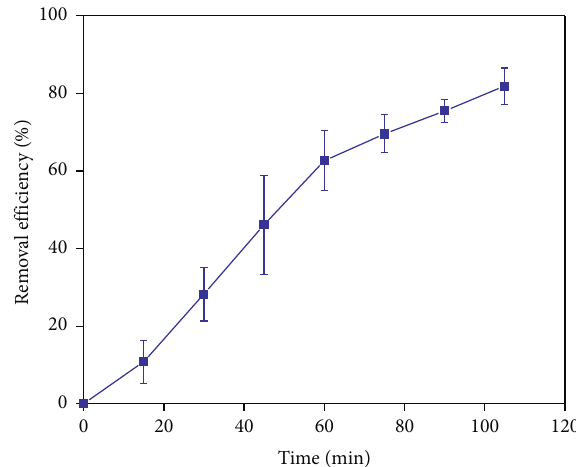
Figure 3: Removal efficiency of PMX using TNT-500 by time (0.1g